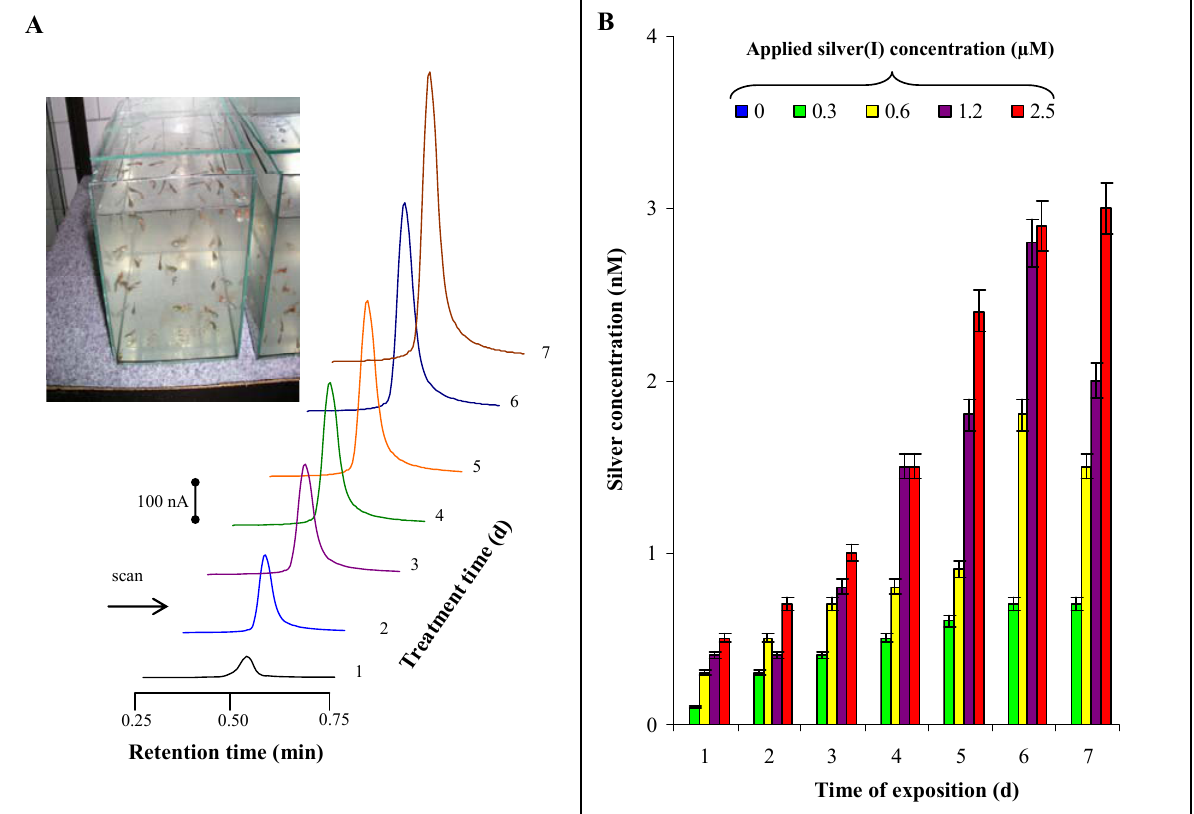
Figure 7. Guppies. (A) HPLC-ED chromatograms of silver(I) ions detected in tissues of fish treated with 2.5 µM silver(I) ions; in inset: guppies in tanks. (B) The content of silver(I) ions in treated